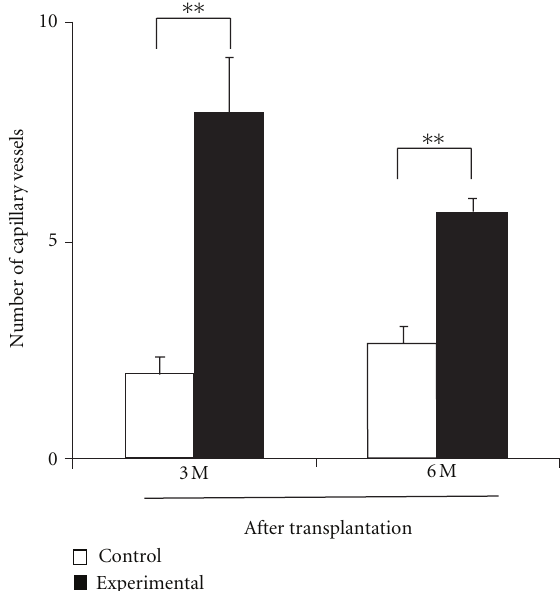
Figure 5: Number of capillary vessels in the regenerated area of artificial jaw cleft. Number of Capillary Vessels in Regenerated Area Was Counted on the Tissue Sections using a Phase Contrast Microscope. N = 3, ∗∗ P < 0 .